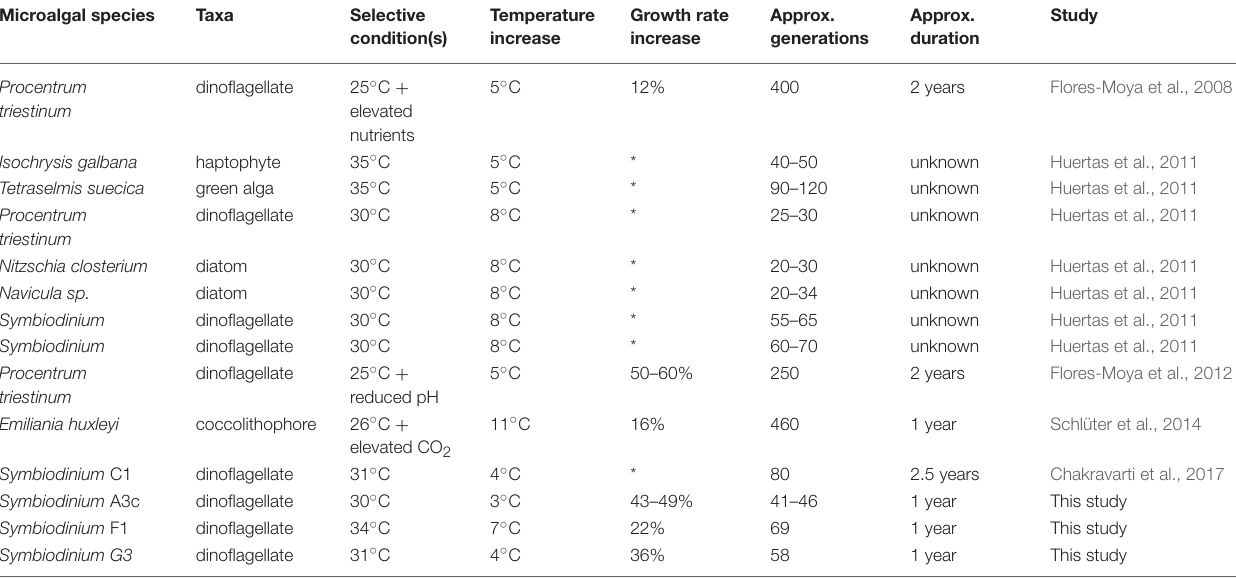
TABLE 3 | Experimental evolution studies on marine microalgae that show an adaptive response to elevated temperature. Microalgal